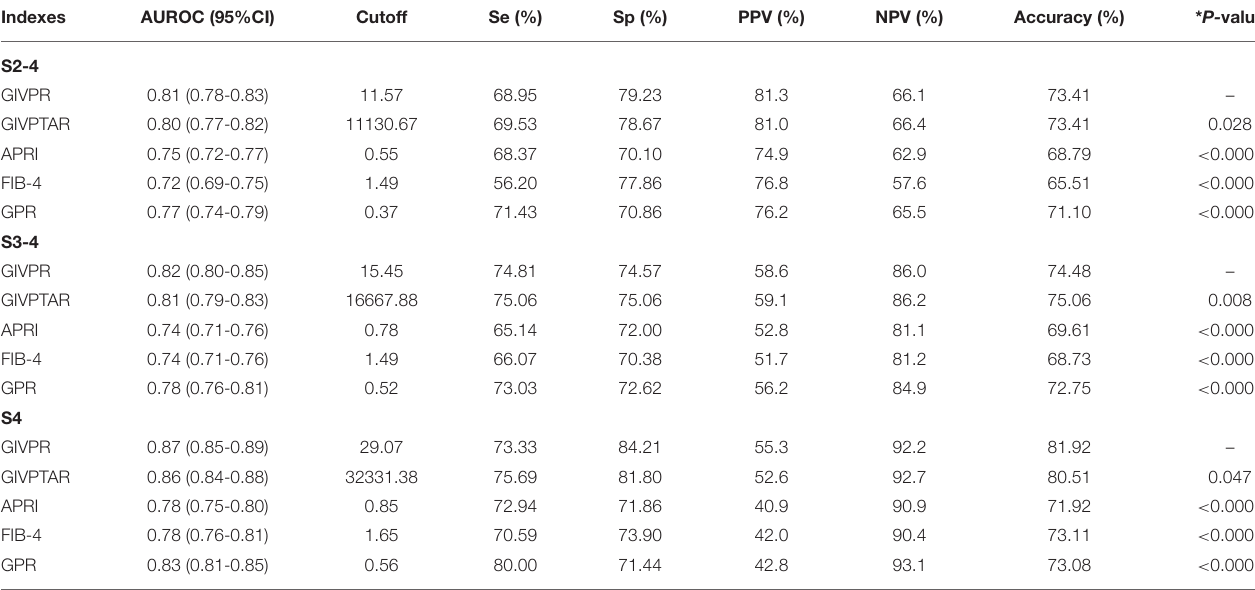
TABLE 3 | Predictive performances of GIVPR, GIVPTAR, APRI, FIB-4, and GPR for liver fibrosis in CHB patients (Training cohort).